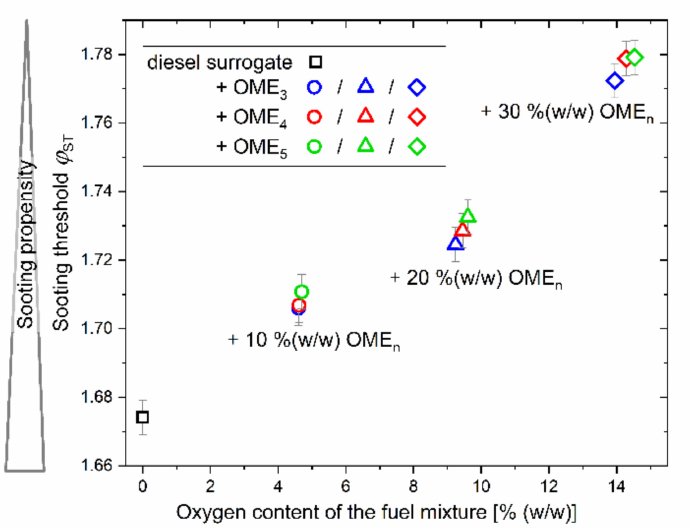
Figure 7. Results of the determined sooting propensities using the soot threshold ( ϕ ST ) as